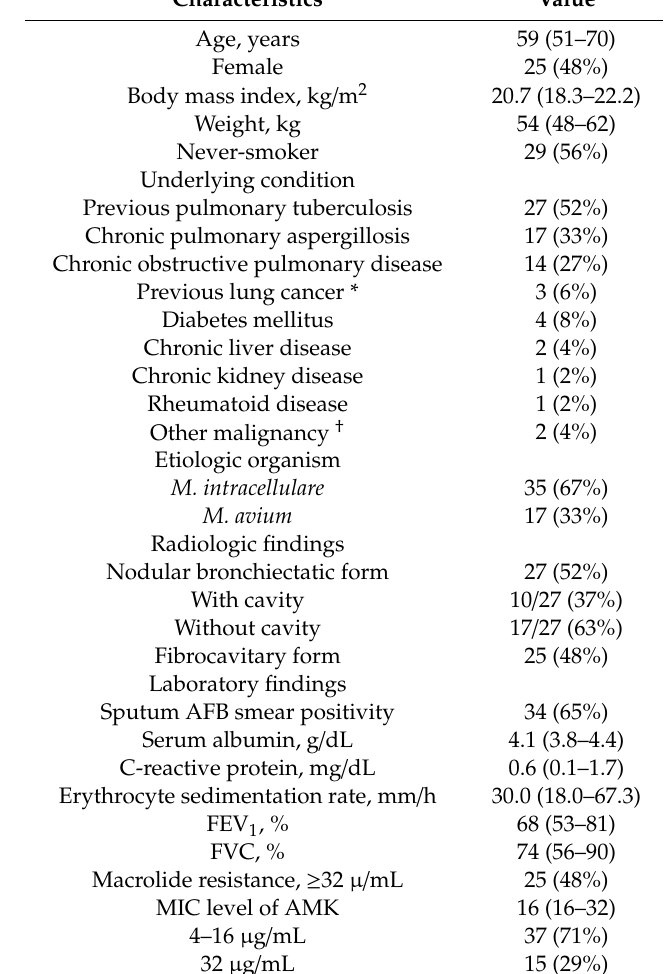
Table 1. Characteristics of the 52 patients at initiation of inhaled AMK with CFZ